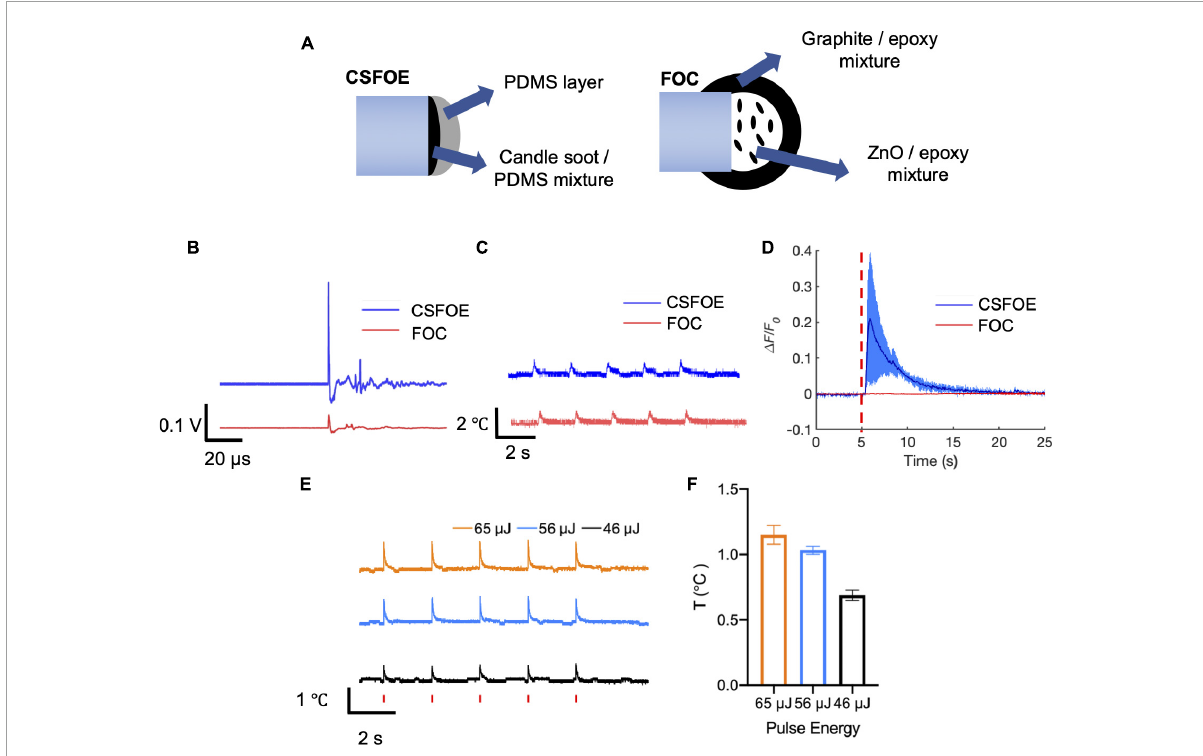
FIGURE4 Comparison of CSFOE and FOC. (A) Schematics of the CSFOE and FOC. (B) Photoacoustic signal of CSFOE and FOC, measured by a 5 MHz transducer under the same laser condition: 1,030 nm, 3 ns, 1.7 kHz, 48 mW. (C) Temperature rise measured by a thermal probe placed at the surface of CSFOE and FOC, respectively. (D) Representative calcium traces of GCaMP6f transfected neurons stimulated by CSFOE (Blue) and FOC (Red) under the same laser energy input of 56 µ J. (E) Temperature rise measured by the thermal probe placed at ∼ 10 µ m away from CSFOE under the laser energy used in neuromodulation experiments. Red vertical bars indicate the laser on. Laser condition: 1,030 nm, 1.7 kHz repetition rate, 3 ms duration for each burst. Laser pulse energy is shown in the figure. (F) Measured maximum temperature increases at corresponding pulse energy inputs ( N = 5 for each